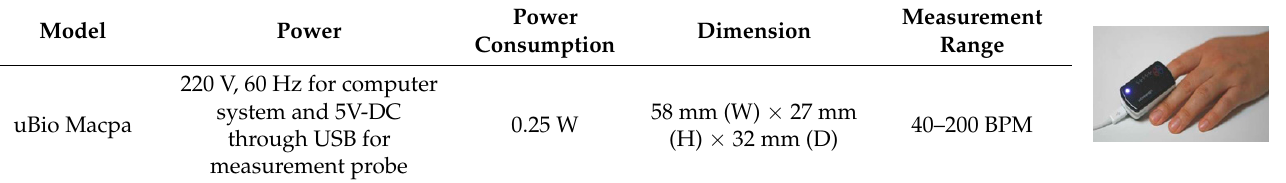
Table 8. Specifications of the measurement device for HRV (uBio Macpa).